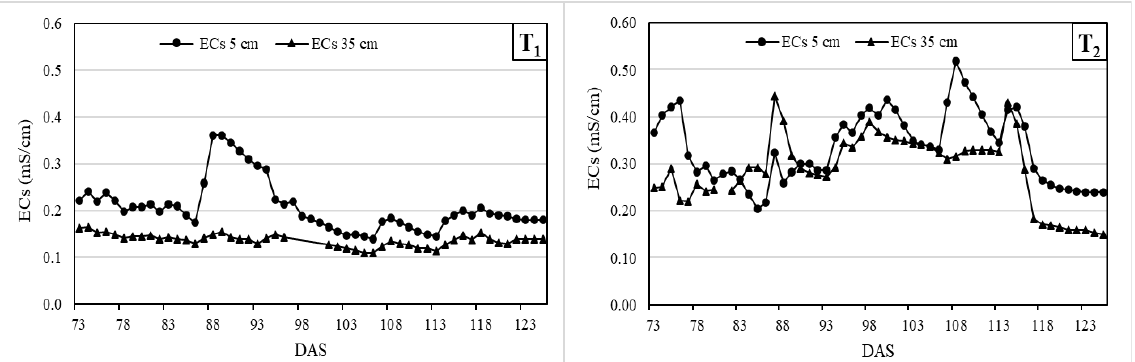
Figure 5. Daily patterns of electrical conductivity (ECs) at 5 and 35 cm under fresh water (T 1 ) and domestic treated wastewater (T 2 ). DAS: days after sowing.